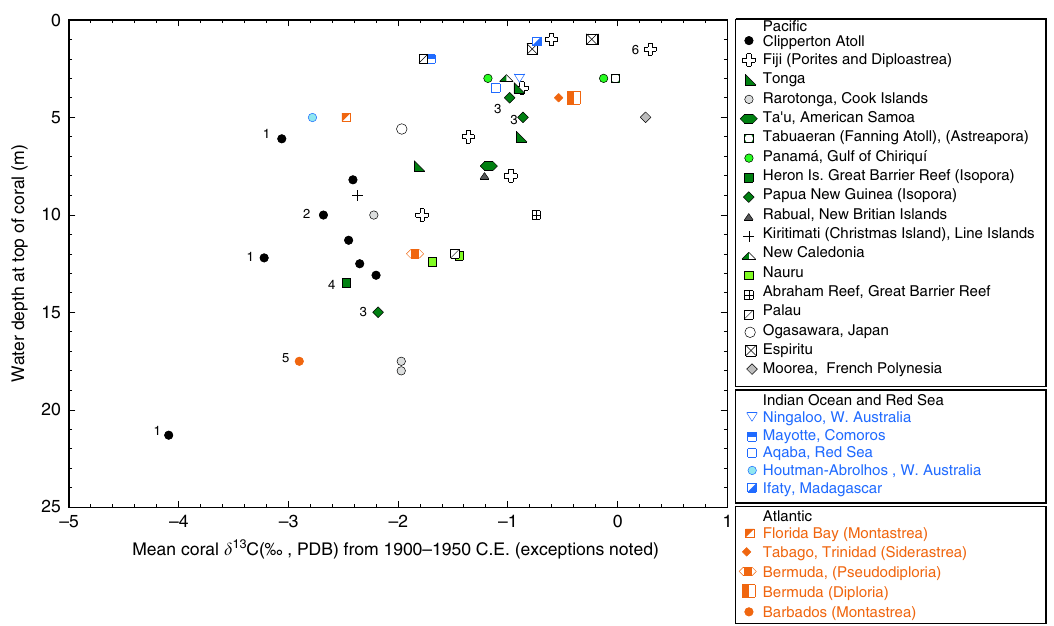
Fig. 5 Coral skeletal δ 13 C to water depth comparison: mean coral δ 13 C compared against water depth at top of coral for different locations and coral genera based on our own records and a literature search compilation. Most sites are in the Paci fi c. Those corals that are not Porites are indicated in legend. Where possible, mean coral δ 13 C was calculated over the period from 1900 to 1950 to avoid the interval of most pronounced 13 C Suess effect because the magnitude of the 13 C Suess effect varies with region. Sites with shorter records after 1950 are indicated with numbers (1 = Clipperton 1990 – 1994; 2 = Clipperton Pavona (1946 – 1958); 3 = Papua New Guinea Isopora (1970s); 4 = Heron Is. Isopora (2008 – 2012); 5 = Barbados Montastrea (1976 – 1978)). The black open cross numbered 6 is a Fiji Diploastrea . Despite the different coral genera and wide spatial array of sites, the results indicate a decrease in coral δ 13 C with growth position water depth of ~1.4 ‰ per 5 m of depth ( R = 0.67, p < 0.01) (see Supplementary Fig. 1). If all the corals with δ 13 C data younger than 1950 are removed the relationship is − 1.5 ‰ per 5 m of depth ( R = 0.60, p < 0.01) (see Supplementary Fig. 2). Source data are provided as a Source Data fi le in the Supplement. References for coral δ 13 C data are also included in the